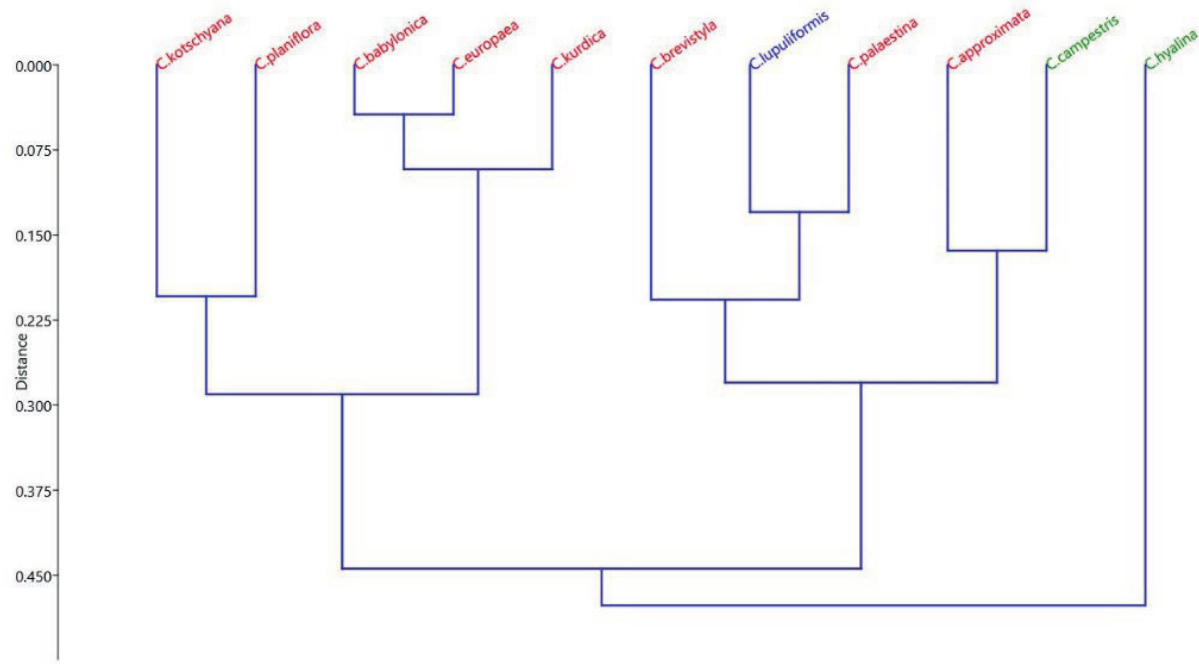
Figure 5. Cluster analysis according to karyotype characteristics Show that 3 main groups (Same colored taxa are located in the same sec-